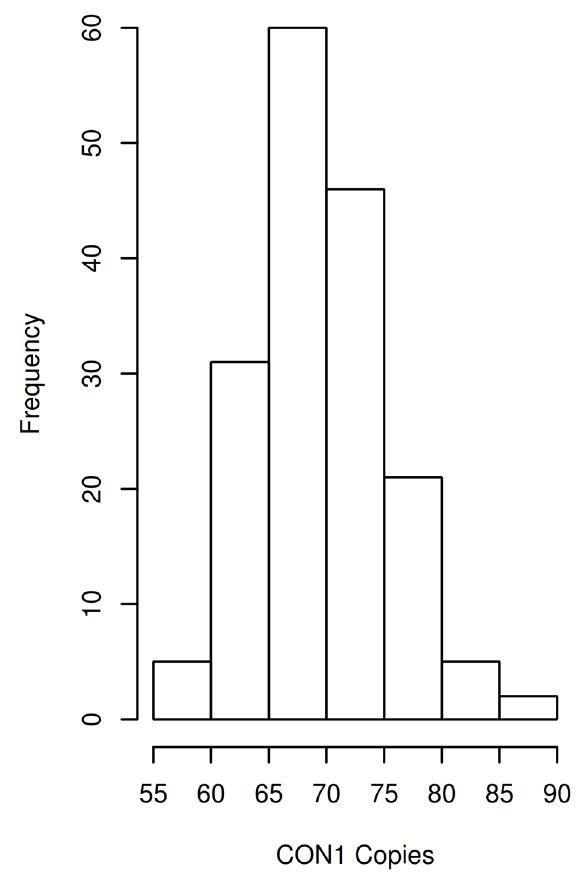
Figure 1. DUF1220 CON1 copy number distribution in individuals with ASD. CON1 copy numbers were determined for 170 individuals with ASD. CON1 copy number ranges are indicated. Frequency denotes the number of individuals who exhibited the indicated copy number range.